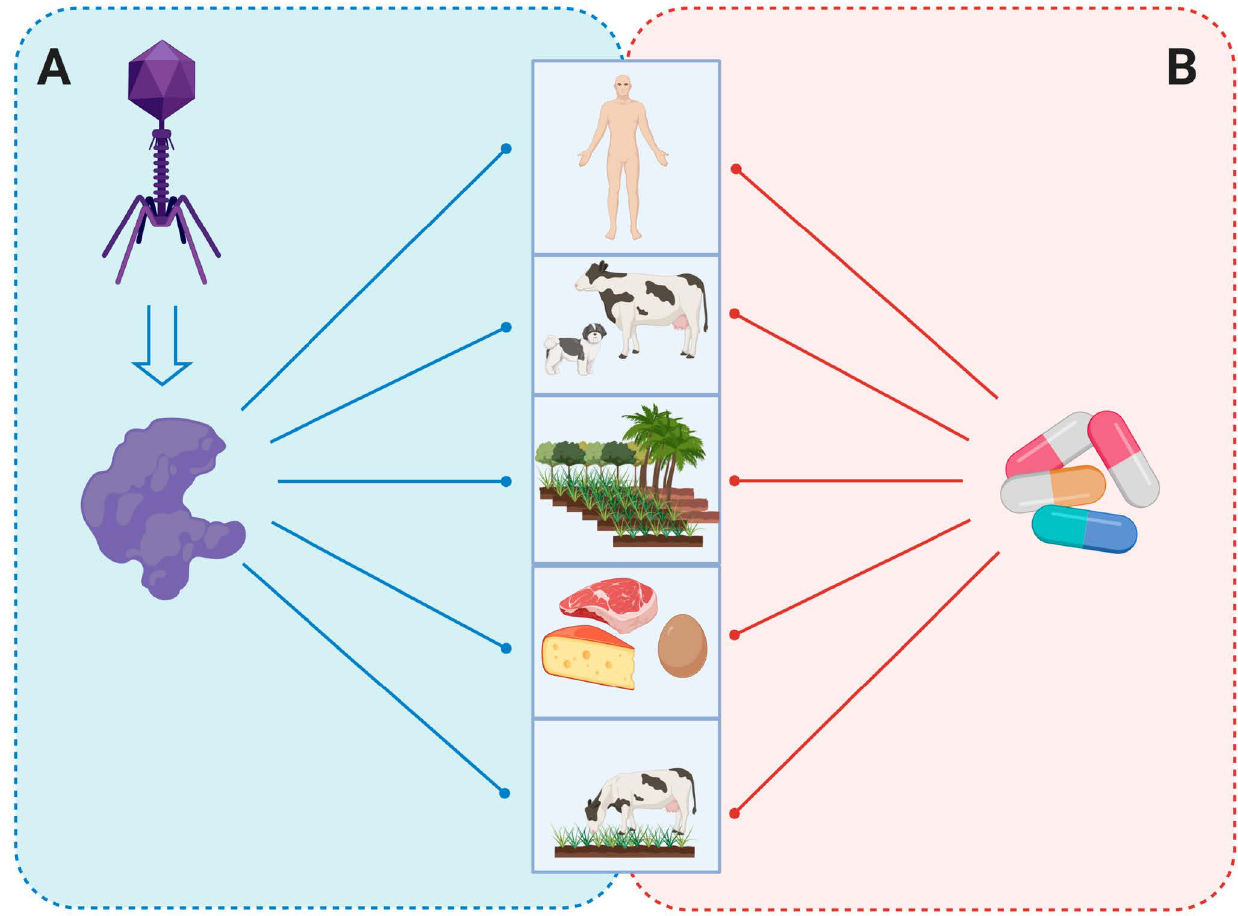
Figure 6. Bacteriophage endolysins as an antibacterial agent. ( A ) Phage-derived endolysin protects humans, animals, plants that are extremely infected with antibiotic-resistant pathogens and also inhibits the prevalence of antibiotic resistance via other food chains. ( B ) Overuse of antibiotics in food chains and human and veterinary medicine causes uncontrollable bacterial infections with multidrug resistance that leads to future